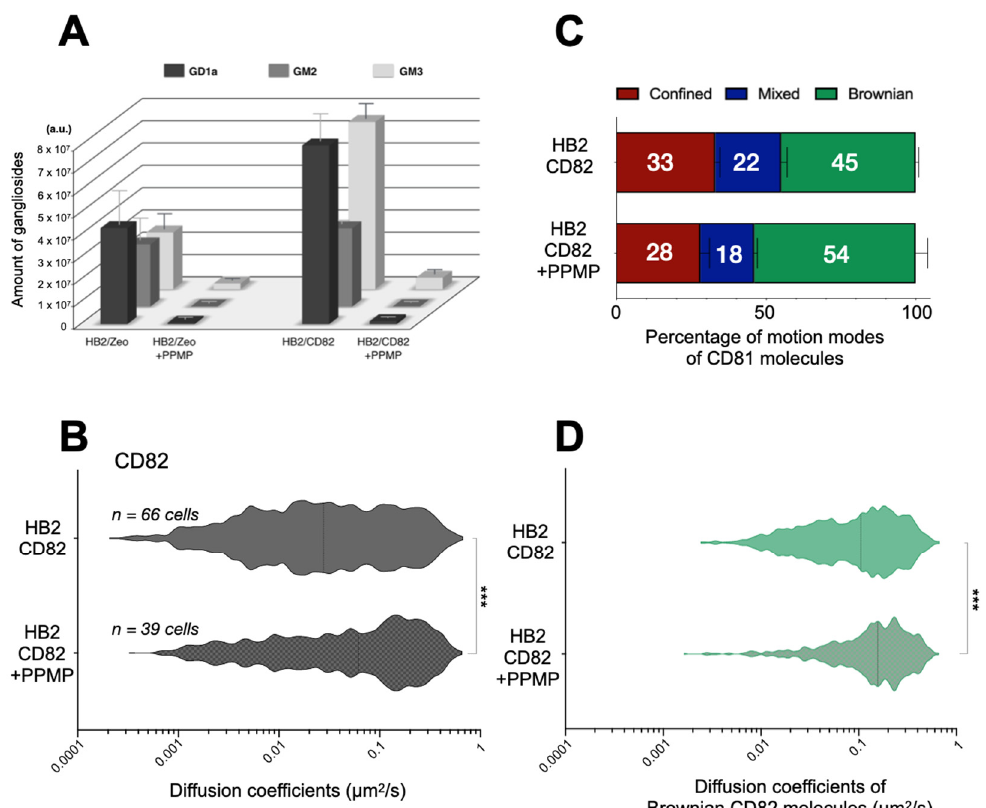
Figure 4. ( A ) Mass spectrometry analysis of ganglioside expression in HB2/Zeo or HB2/CD82 treated or not with PPMP. The analyses have been done in triplicate with samples containing 10 6 cells. The error bars represent the SEM of three independent experiments. ( B ) Distribution of the apparent diffusion coefficients calculated for all the individual CD82 molecules analyzed in HB2/CD82 cells treated or not with PPMP. The violin plots were built with 1000 trajectories for each condition. ( C ) Histograms representing the percentage of CD82 molecules exhibiting Brownian, confined and mixed mode relative to the total number of trajectories in HB2/CD82 cells treated or not with PPMP. The error bars represent the standard deviation of at least three independent experiments. ( D ) Distribution of the apparent diffusion coefficients of Brownian CD82 molecules. *** indicate that the difference between the two populations is significant with a p value below 0.0001 as determined by the Mann–Whitney U test. PPMP treatment of HB2/CD82 cells did not modify the lateral diffusion of CD9 at the plasma membrane (Figure 5B) but increased the diffusion of CD81. This effect of PPMP on CD81 dynamics did not require CD82 expression since PPMP had an even more pronounced effect on the diffusion of CD81 in HB2/Zeo cells (0.02 µ m 2 /s versus 0.07 µ m 2 /s upon PPMP treatment). By contrast, the increase in CD81 median diffusion in PPMP-treated cells appears to be a consequence of an increase in the proportion of Brownian trajectories since we observed no impact on the diffusion coefficient of CD81 molecules displaying Brownian motion after the